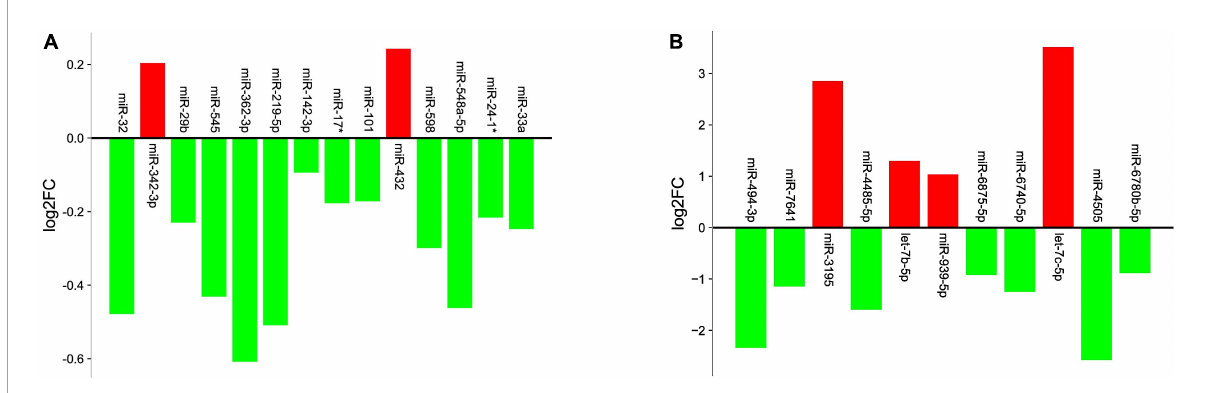
FIGURE1 Graph illustrating the differential expression levels of miRs obtained from (A) GSE24591 dataset (B) GSE148153 dataset. X-axis represents the miRs and Y-axis represents logarithmic fold change (log 2 FC) of the miR expression levels. Red columns indicate upregulation; green columns indicate downregulation.